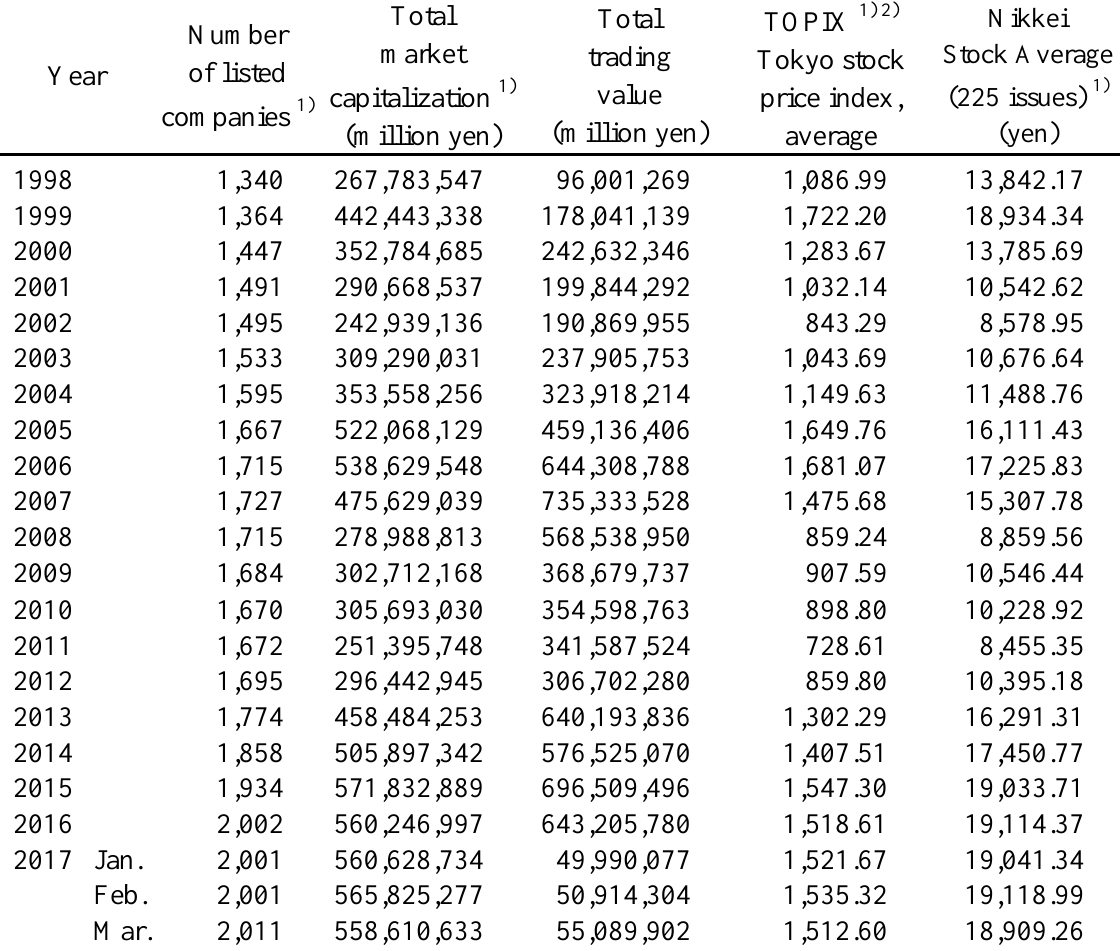
Stock Prices (Tokyo Stock Exchange, first